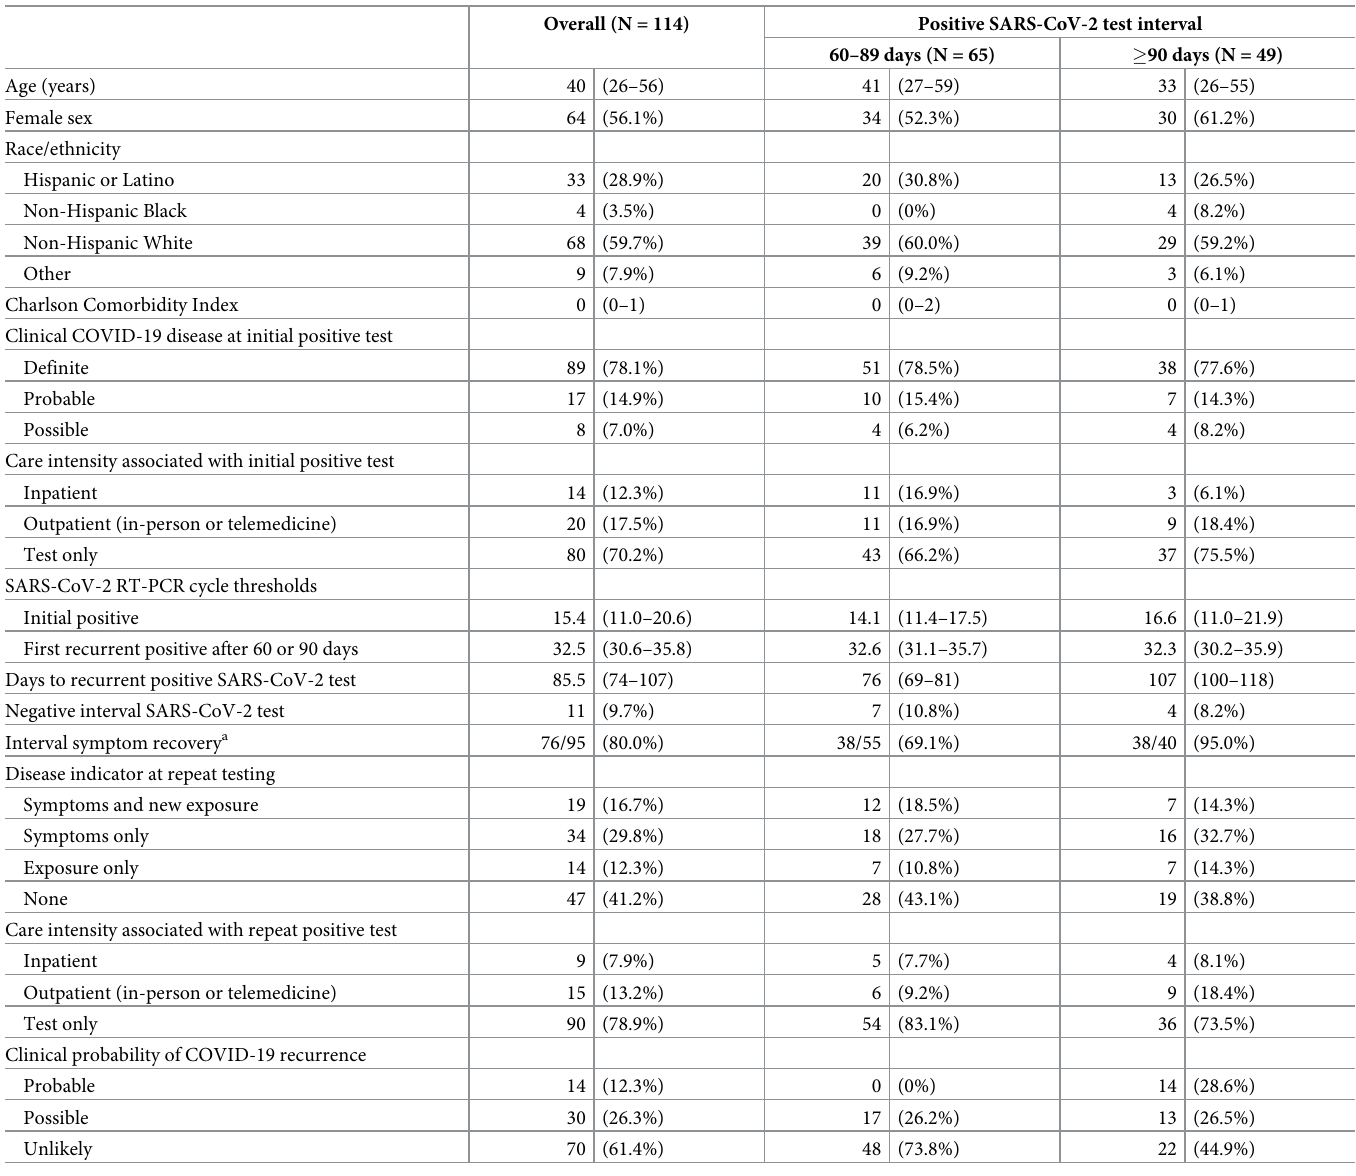
Table 2. Patient demographic and clinical